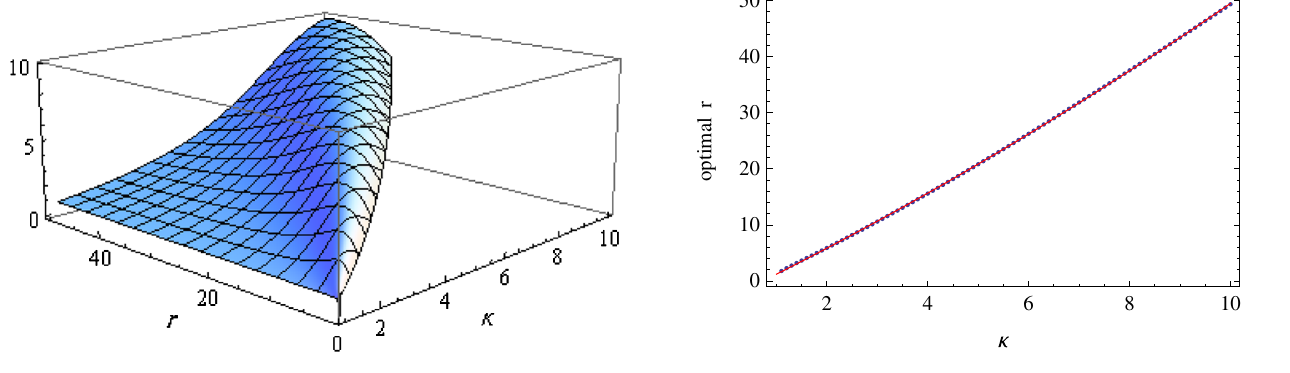
¼ (cid:5) =(cid:5) opt max 0